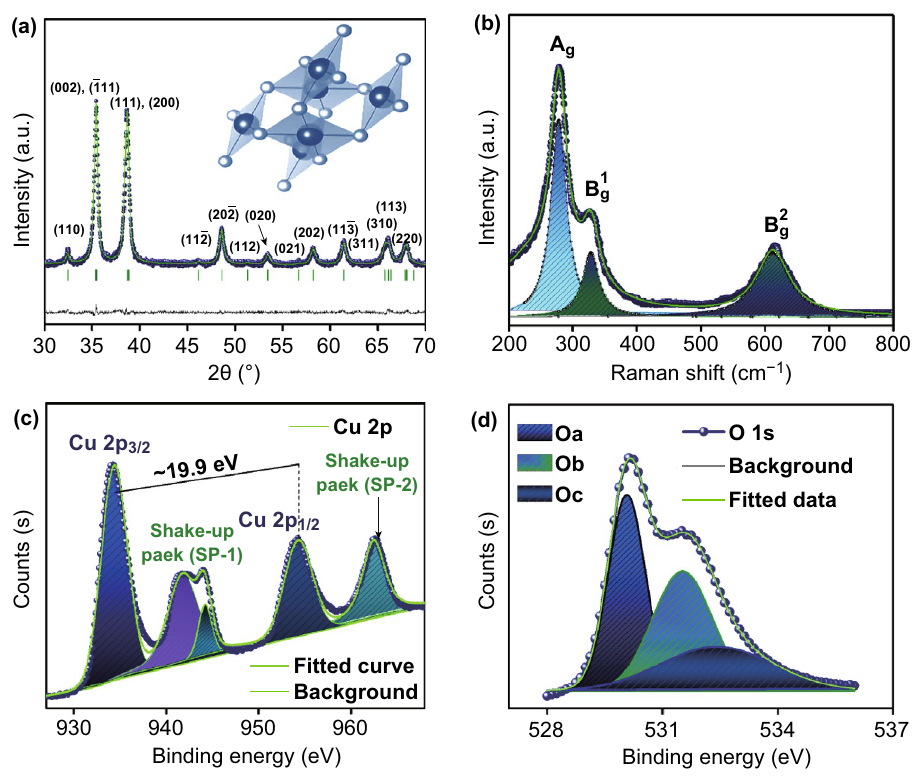
Fig. 2 a Rietveld refinement of the XRD pattern and b Raman spectrum of eugenol-assisted CuO nanoflowers with the high-resolution fitted XPS spectrum of c Cu 2p and d O 1s. (Color figure